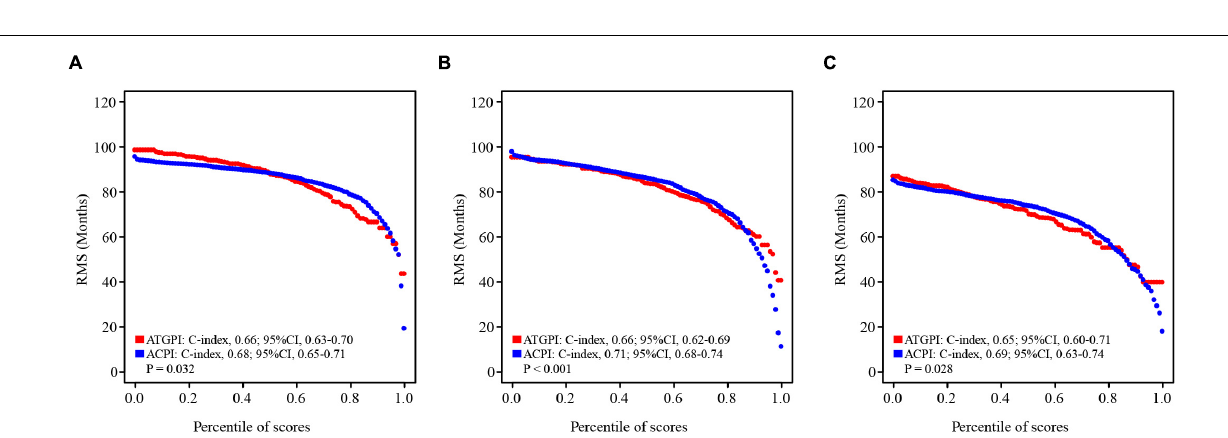
Frontiers in Cell and Developmental Biology |